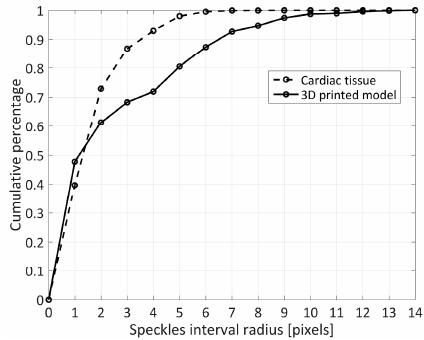
Figure 5. Cumulative percentage of speckles radius.